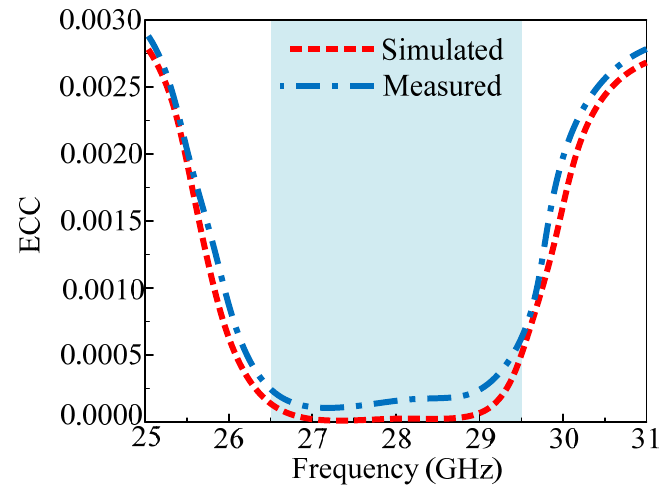
Figure 12. Simulated and measured ECC of the proposed antenna.